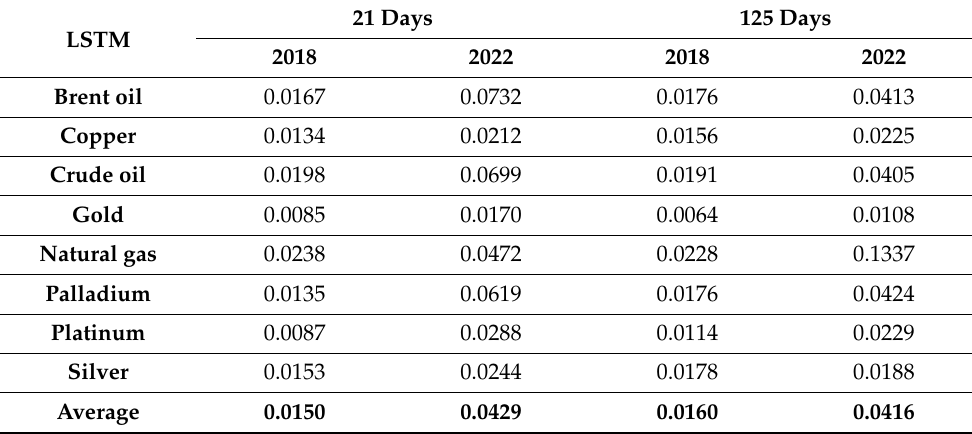
Table 14. Long-Short-Term Memory (LSTM) forecast